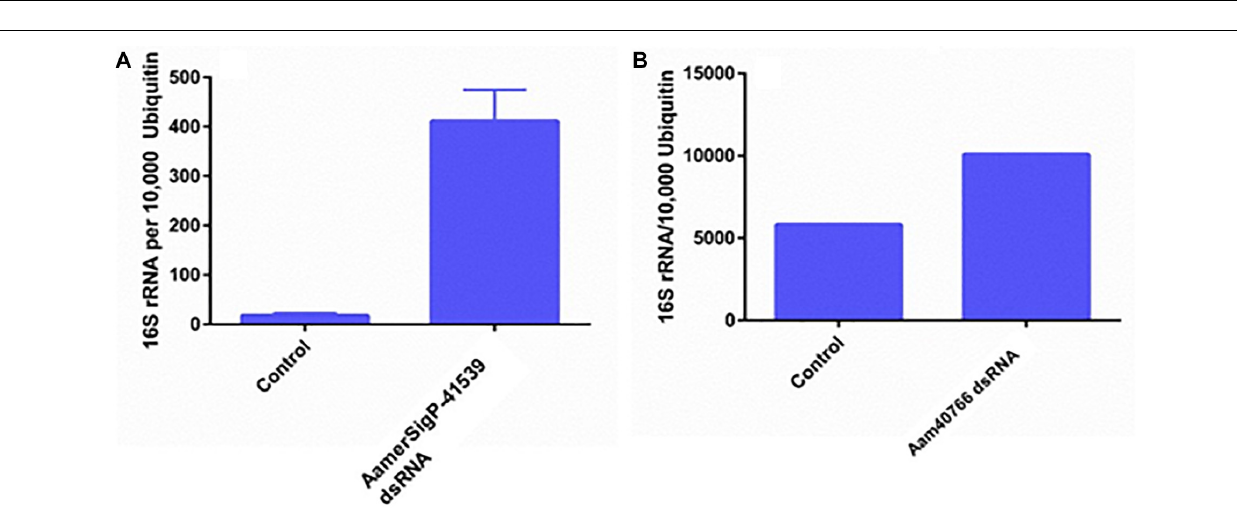
FIGURE 5 | Total bacterial load in GRP silenced tick tissues. The ticks from both irrelevant dsRNA (GFP) and target genes were blood feed and partially fed ticks were removed from the host past 5 days infestation. Within 2 h of tick removal from the hosts, the ticks were dissected to isolate salivary glands and stored in RNAlater before RNA extraction and cDNA synthesis. Total bacterial loads were estimated by qPCR and reference to ubiquitin in the tick salivary glands. (A) Changes in 16S rRNA abundance after depletion of AamerSigP-41539. (B) Changes in 16S rRNA abundance after depletion of